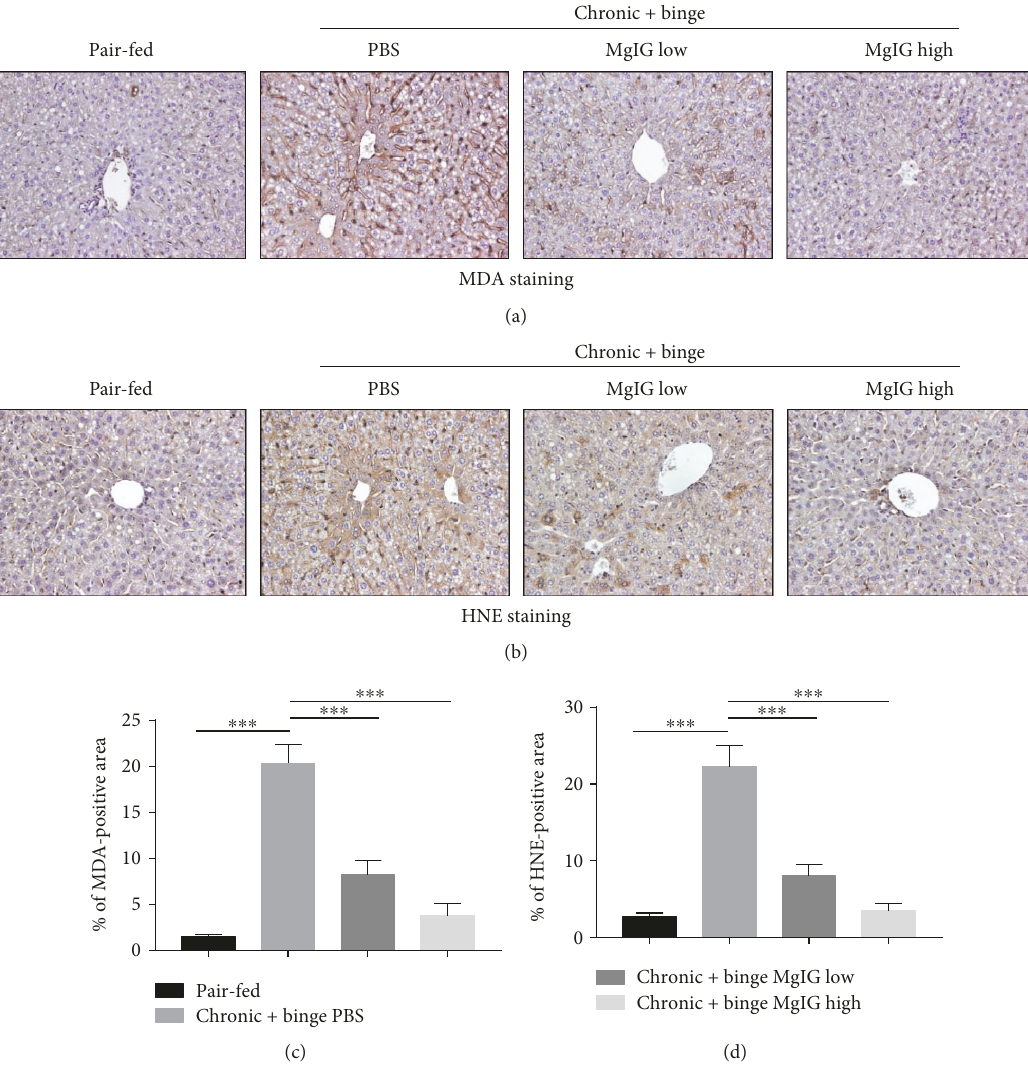
Figure 5: MgIG ameliorates chronic plus binge ethanol feeding-induced oxidative stress in the liver. Liver tissues were subjected to immunostaining with (a) an antimalonaldehyde (MDA) or (b) anti-4-hydroxynonenal (HNE) antibody. (c and d) Quanti fi cation of (a) and (b). Values represent means ± SEM. ∗∗∗ p < 0 001